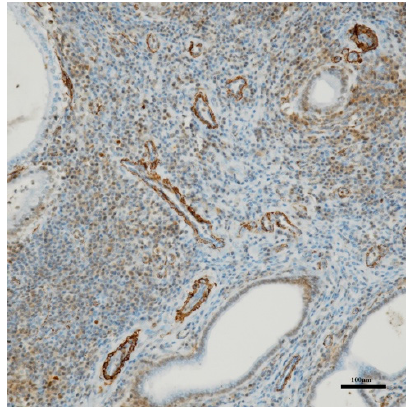
Figure 5. Uterus. Strong positive CD-34 reaction in the vascular endothelium. (10×).